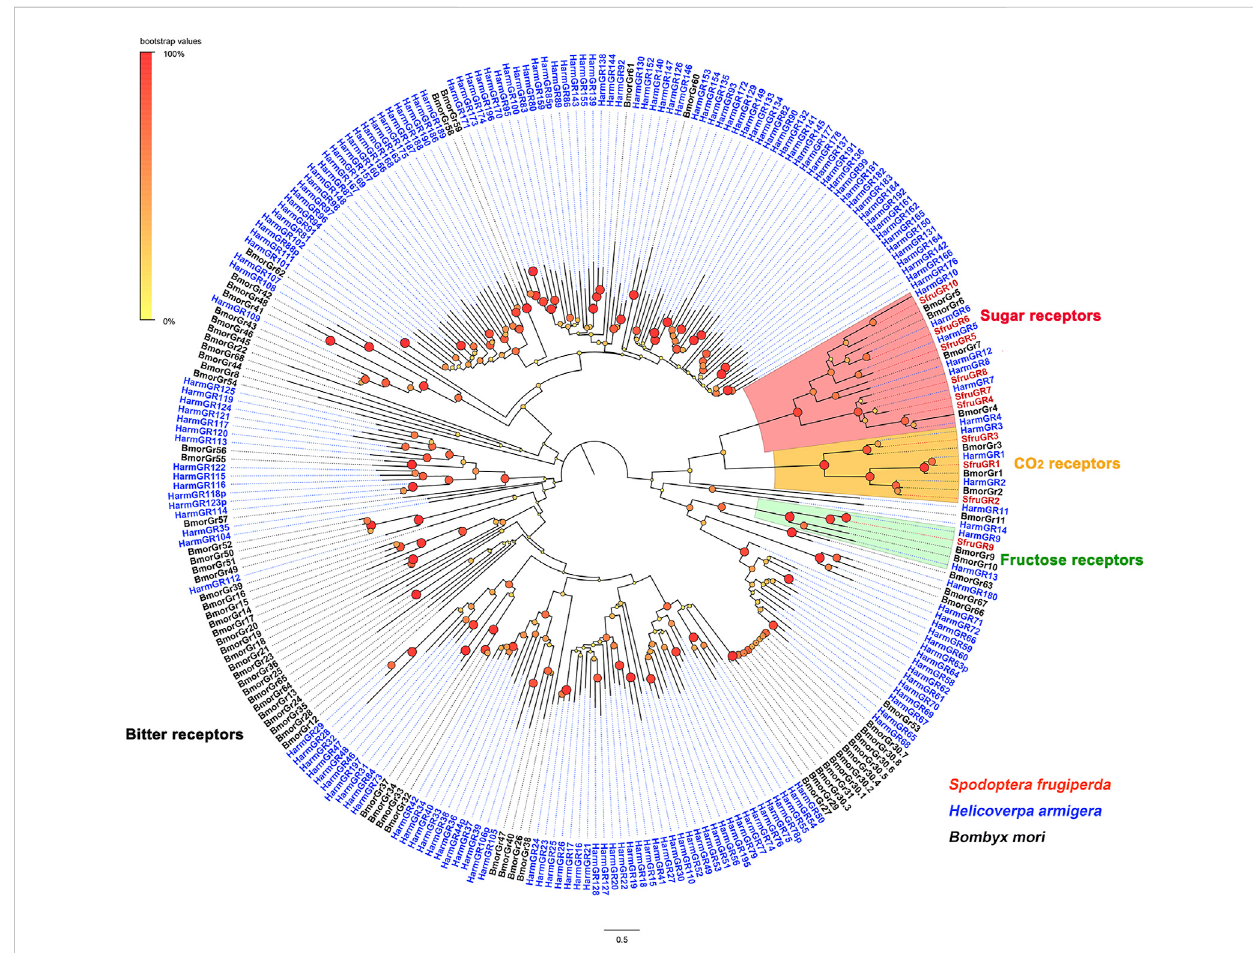
FIGURE 4 Phylogenetic analysis of the candidate SfruGRs from the transcriptome of S . frugiperda tarsi and GRs from H . armigera and B . mori .